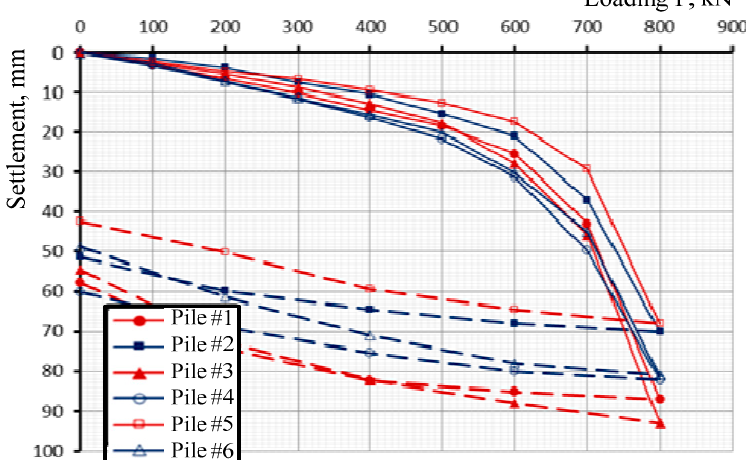
Figure 10. Correlation of loading P with settlement S according to the SLT results of the ordinary piles (with soil wetting).